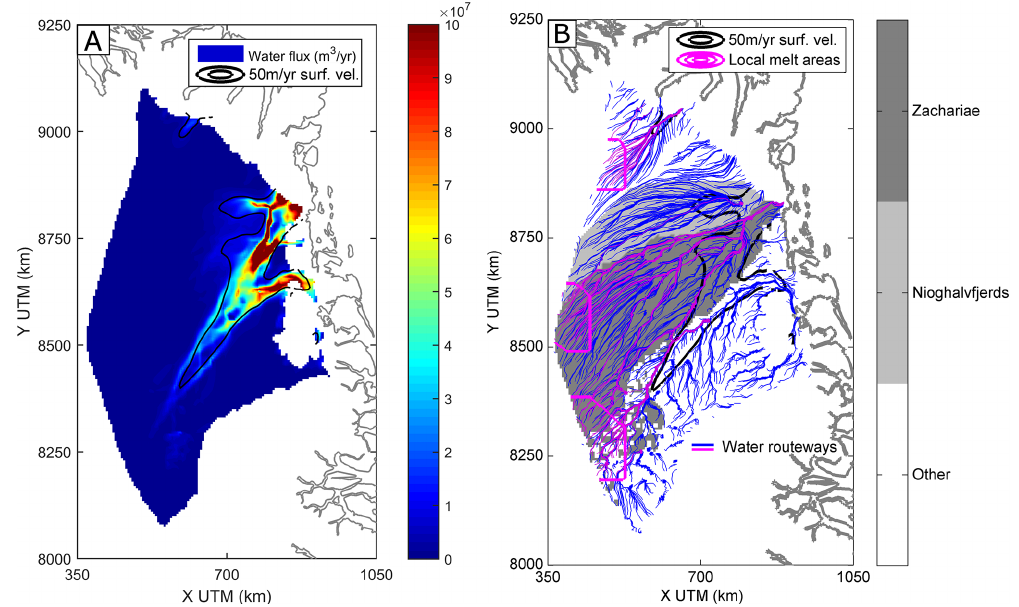
Figure 5. (a) Subglacial water flux for upper values of basal melt rates. (b) Water routeways for the present-day topography; the background colours indicate which outlet the subglacial water is draining into. The magenta contours indicate the areas of localised basal melt from the study by Oswald and Gogineni (2008). The contour for the 50myr − 1 surface velocity (from Joughin et al., 2010) is indicated with thick, black